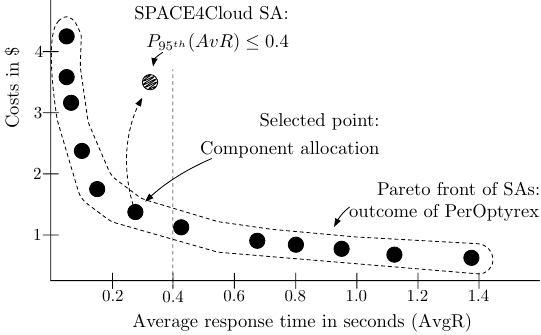
Figure 1: POS: example of